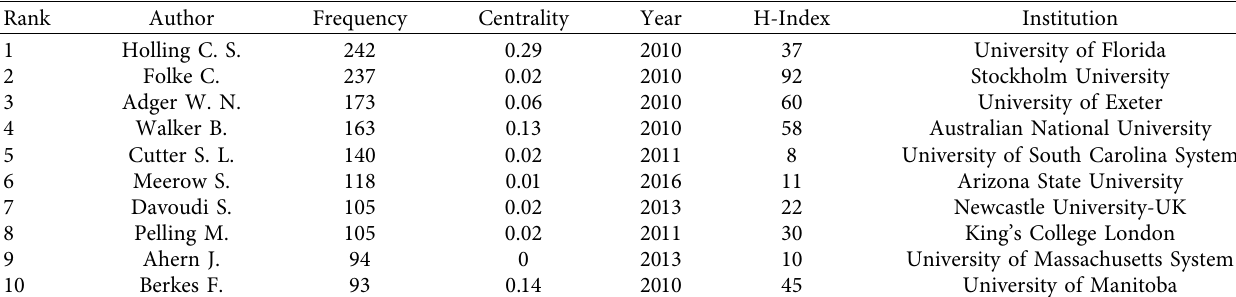
Figure 10: Visualization map of the co-cited author in resilient city Table 6: Top 10 cited authors in the resilient city field from 2010 to 2019.